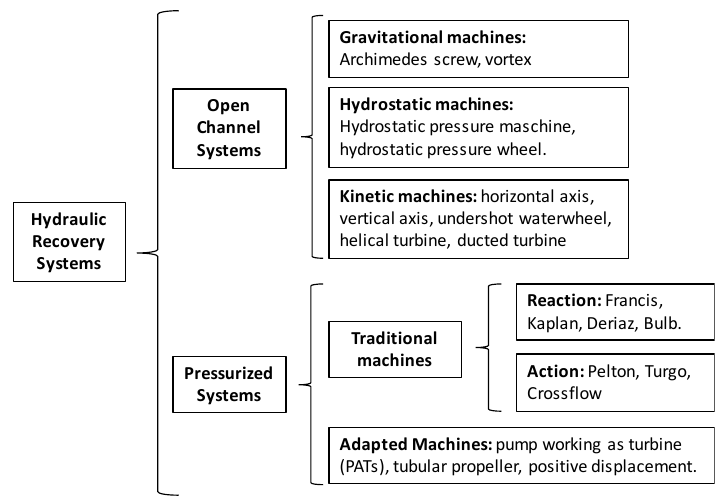
Figure 4. Classification of hydraulic machines.